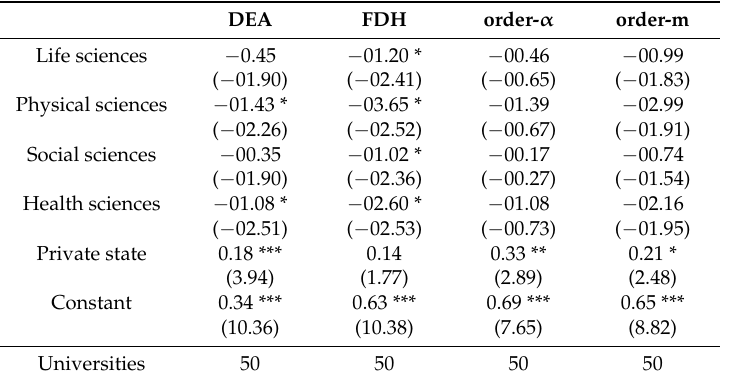
Table 5. Beta coefficients and t statistics of the regression models with the efficiency scores as dependent variable for